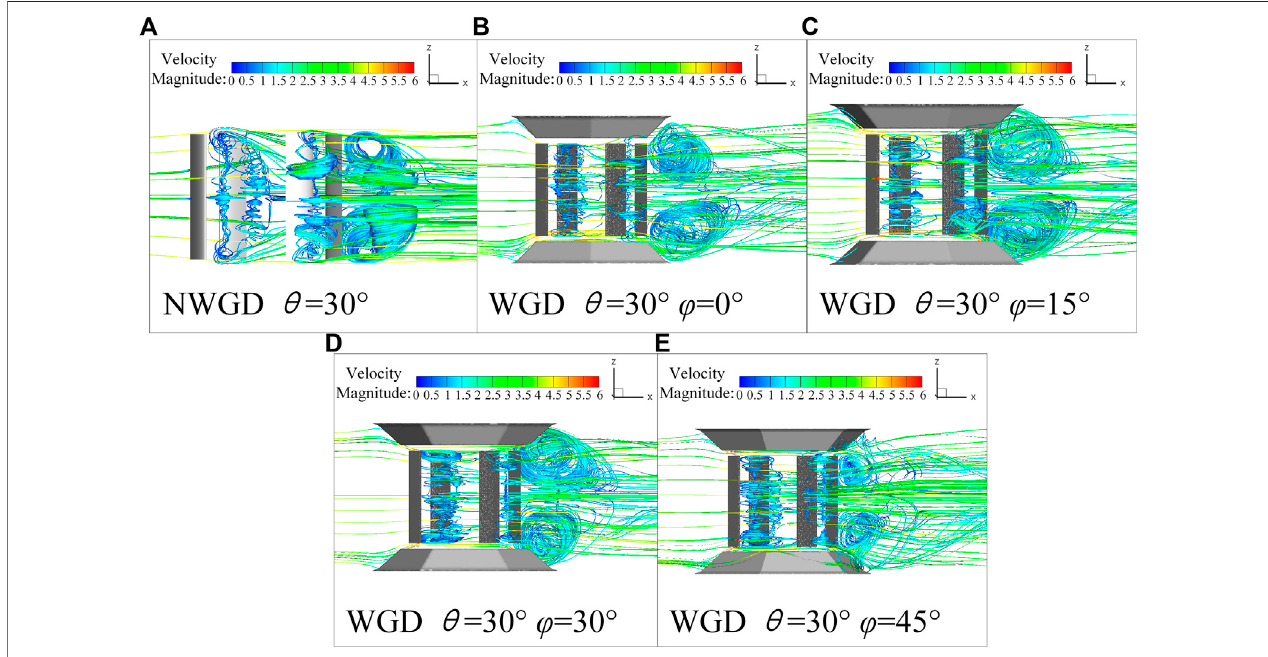
FIGURE 7 | Static streamline comparison at θ = 30 °